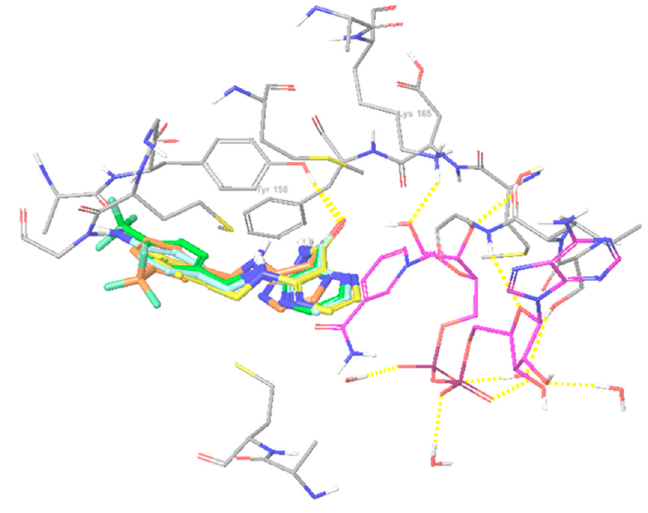
Figure 6. The most active compounds docked into the active site of InhA (enoyl-ACP reductase) ( 4 —orange; 8 —yellow; 9 —aquamarine; 12 —green).